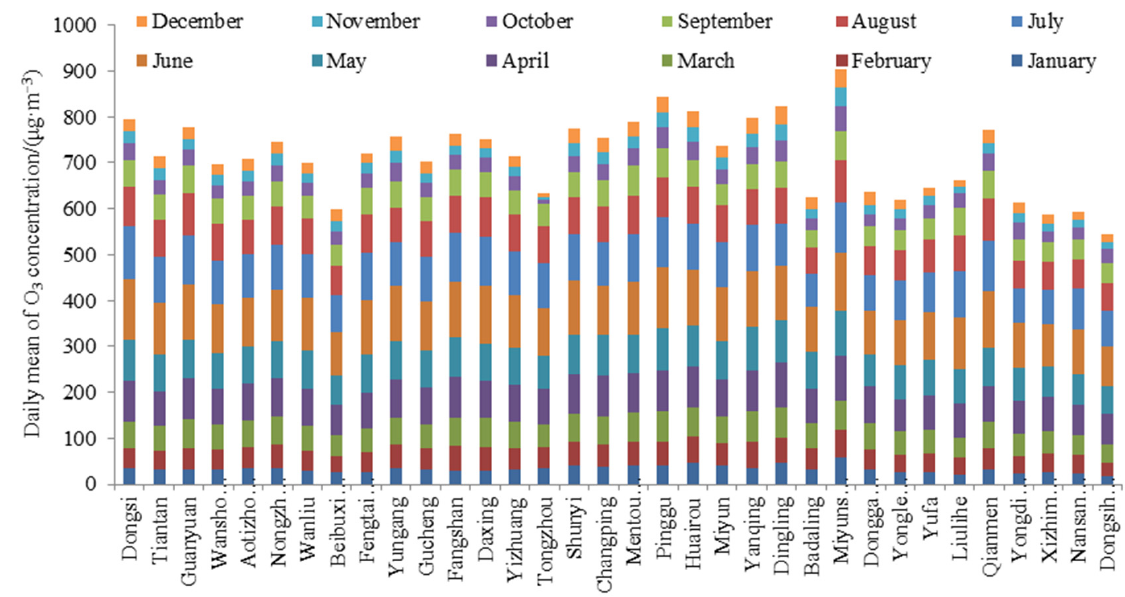
Figure 5. Daily mean of O 3 concentration in each month from the 34 monitoring stations (control station not shown).